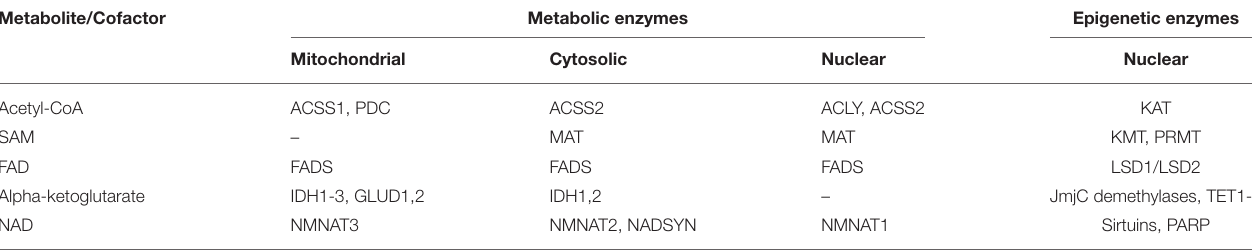
TABLE 1 | Metabolic enzymes involved in the generation of metabolites/cofactors utilized by important epigenetic effectors.